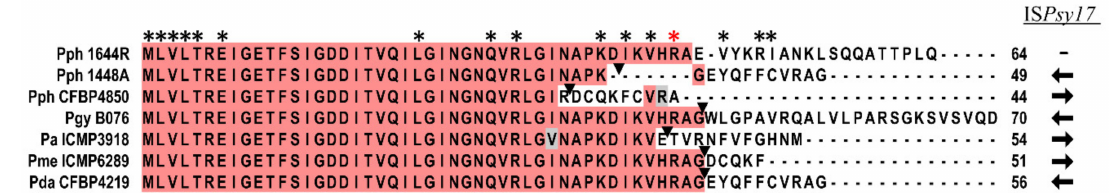
Figure 2. Disruption of gene rsmC by independent insertions of IS Psy17 in diverse strains of genomospecies 2 of Pseudomonas syringae sensu lato. The deduced products of rsmC from the strains shown on the left were aligned using Multalin [49]. Pa, P. amygdali ; Pda, P. amygdali pv. daphniphylli; Pgy, P. amygdali pv. glycinea; Pme, P. meliae ; Pph, P. amygdali pv. phaseolicola. Only the first 70 residues are shown from the 116 residues sequence from Pgy B076. The first sequence, from strain 1644R, is a wild-type full-length allele; black triangles are inserted before the first amino acid modified by the insertion of IS Psy17 and the arrow to the right indicates the orientation of this mobile element. Numbers at the end of the alignment indicate the total number of amino acids for each deduced product. Residues that are identical or similar in at least 50% of the sequences are shaded in red and grey, respectively. Asterisks indicate residues that are important for the interaction between the related proteins RsmA or RsmE with RNA and for the regulation of several phenotypes, with a red asterisk indicating the critical Arg44 residue [67–69].